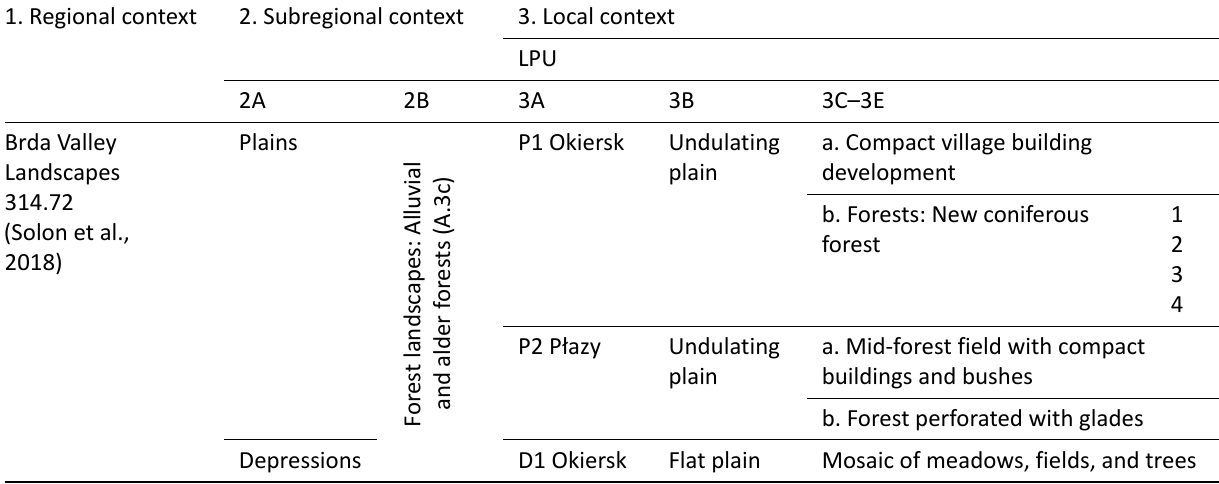
Table 2. Classification of the landscape units of the study area with integrated description of subunits. 1. Regional